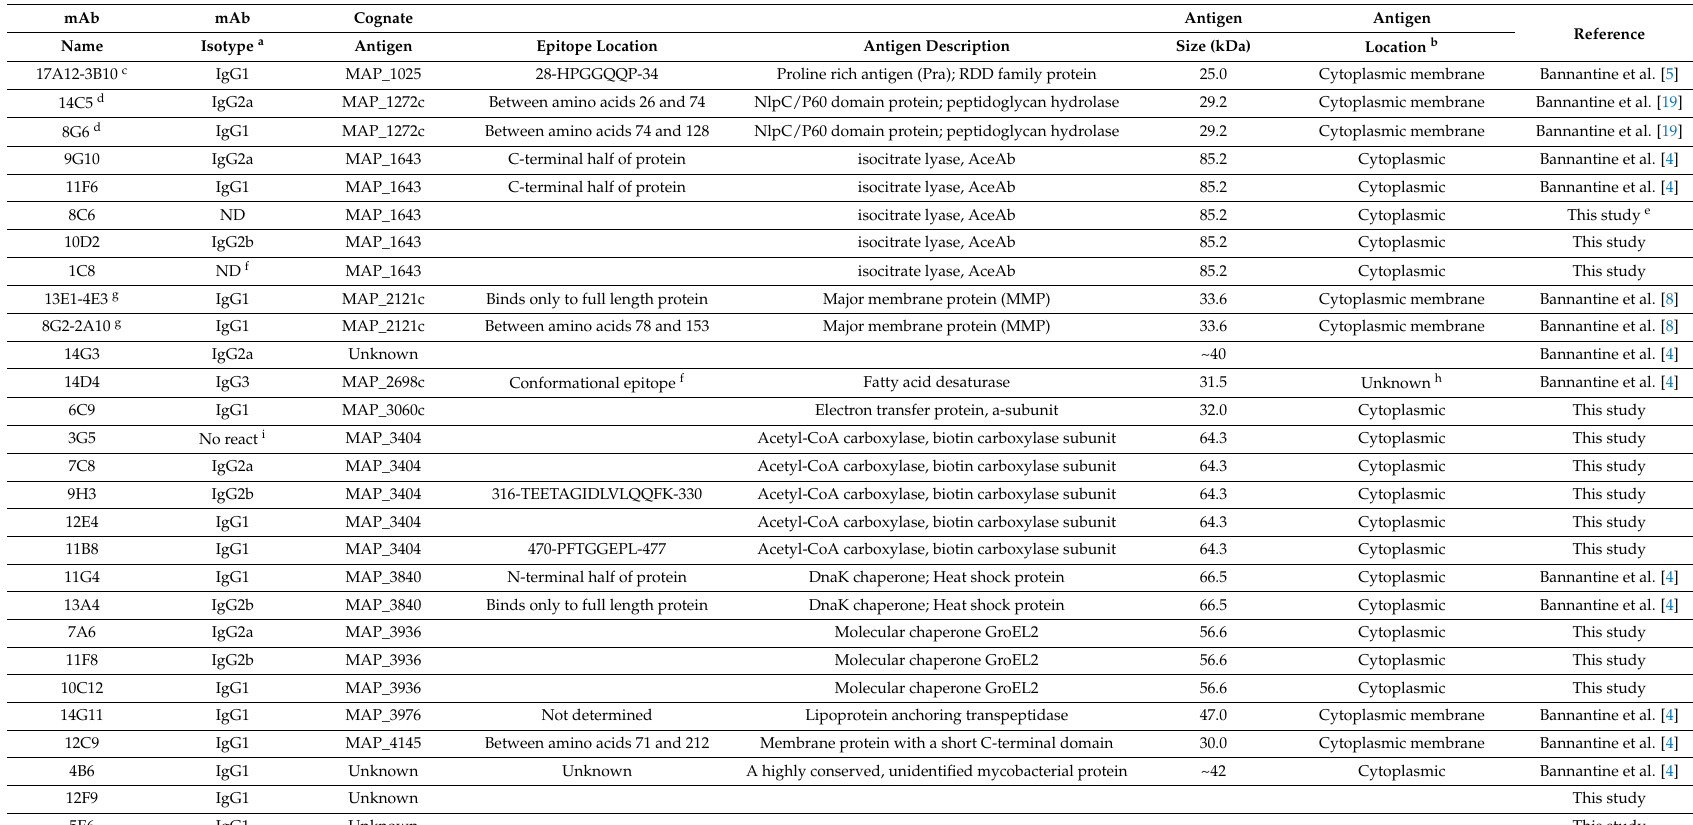
Table 2. Antibodies and corresponding antigen